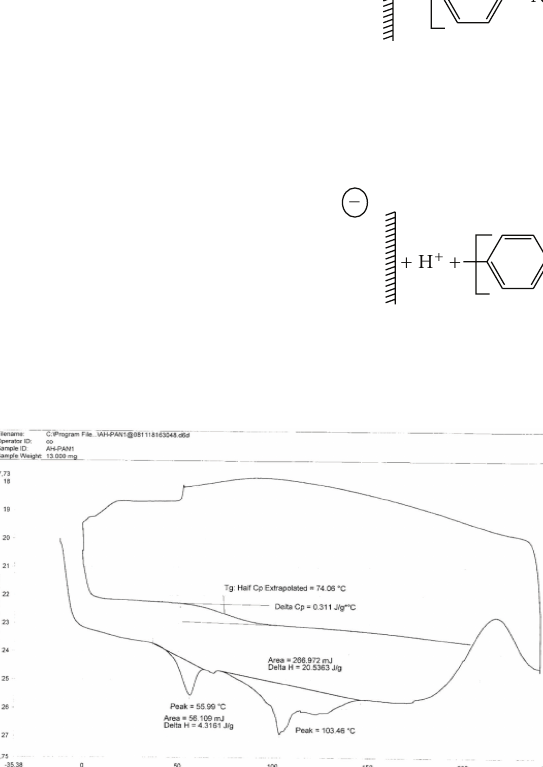
Figure 10: DSC Curve of the PANI-HCl composite obtained in nitrogen atmosphere at heating rate of 10 ◦